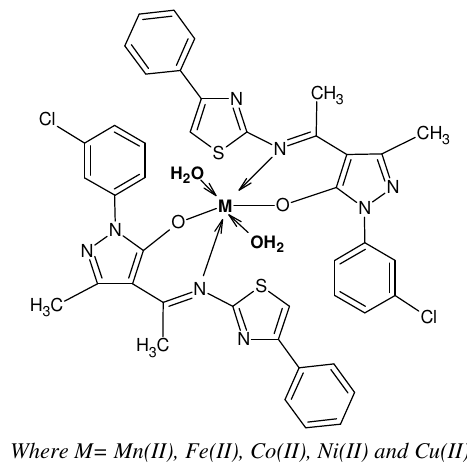
Figure-2. Metal complexes of ligand-L